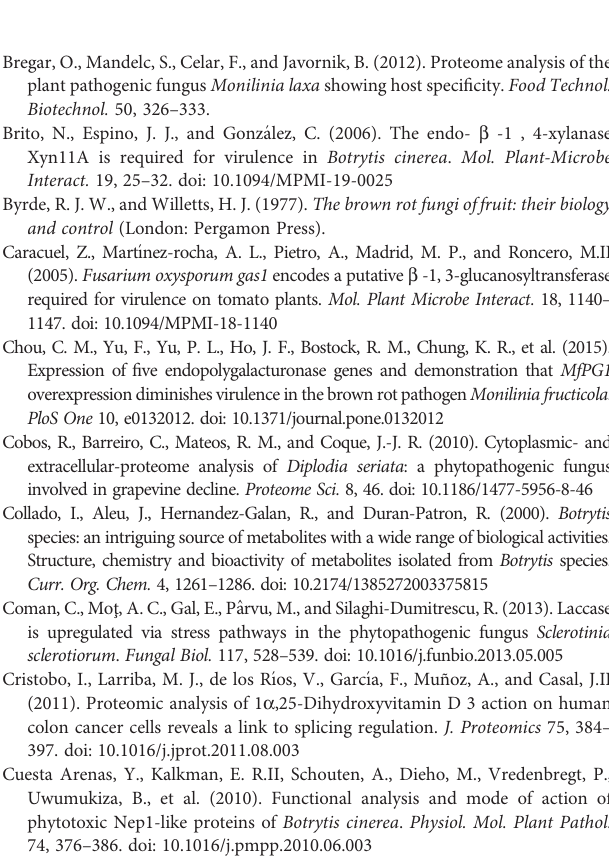
SUPPLEMENTARY TABLE 1 | Details of the whole identi fi ed proteins and peptides through LC-MS/MS in exoproteome of virulent Monilinia laxa isolates 8L and 33L at 3 dpi, and weak virulent isolate 5L at 7